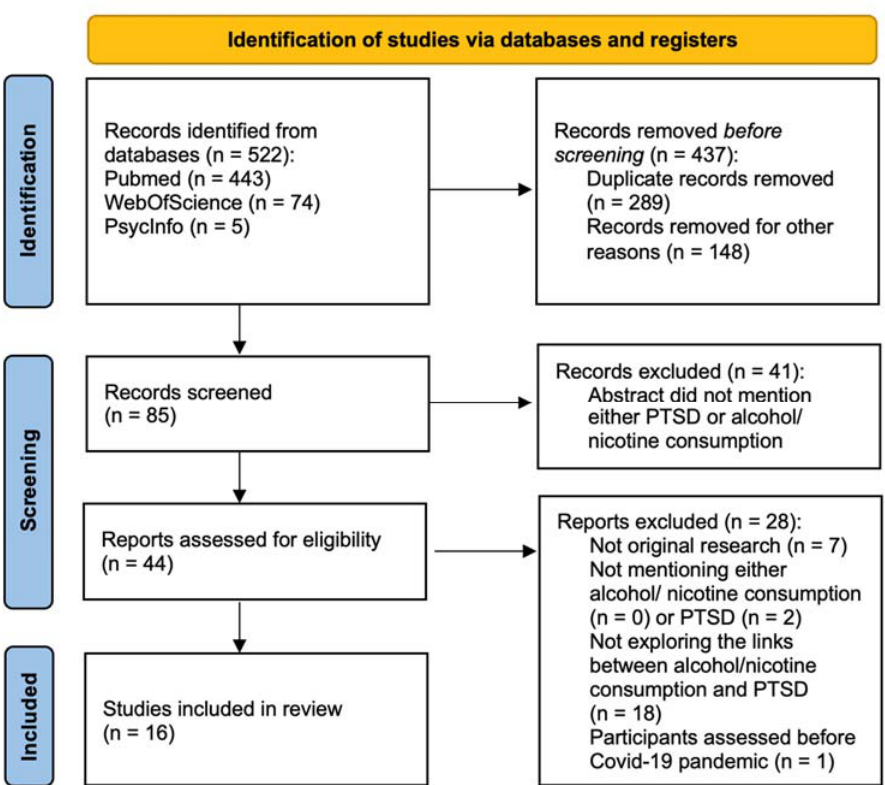
Figure 1. Flow-chart Figure 1. Flow ‐ chart diagram.